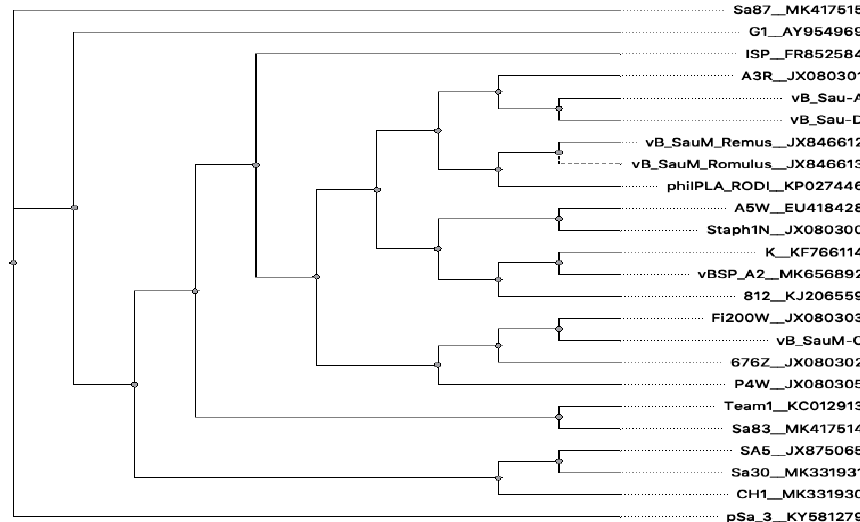
Figure 5. Whole genome phylogeny of selected kayviruses and newly isolated bacteriophages described in this work.